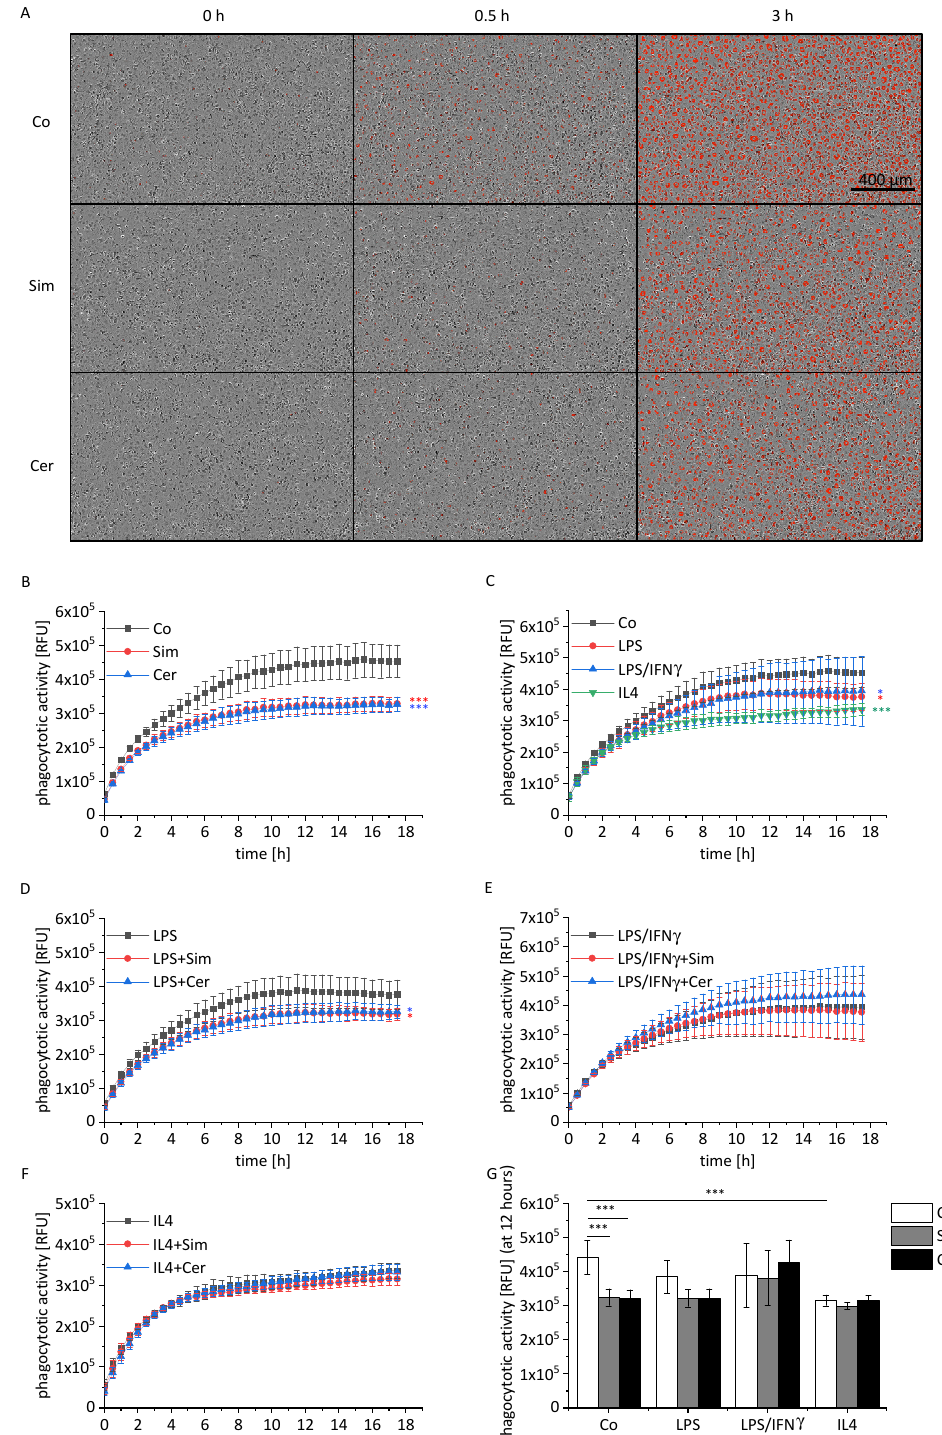
Figure 3. Effect of statin treatment on the phagocytotic activity of macrophages. ( A – G ) BMMs were stimulated for the last 4 h with LPS (100 ng/mL) or polarized towards M1 (LPS, 100 ng/mL; IFN γ , 20 ng/mL), or M2 (IL4, 20 ng/mL) in the presence or absence of simvastatin (Sim, 2 µ M) or cerivastatin (Cer, 0.5 µ M) for 24 h and monitored by an IncuCyte S3 system after addition of fluorogenic pHrodo ® Red S. aureus bioparticles (5 µ g/well). Co = solvent control, RFU = relative fluorescence units. ( A ) Representative pictures at indicated time points are shown. ( B – G ) Quantification of phagocytotic activity expressed as mean red fluorescence intensity normalized to confluence ( n = 4, duplicates). Statistical analysis was performed by two-way ANOVA with Bonholm post hoc test ( B – F ) or one-way ANOVA with Bonholm post hoc test ( G ). * p < 0.05, *** p <